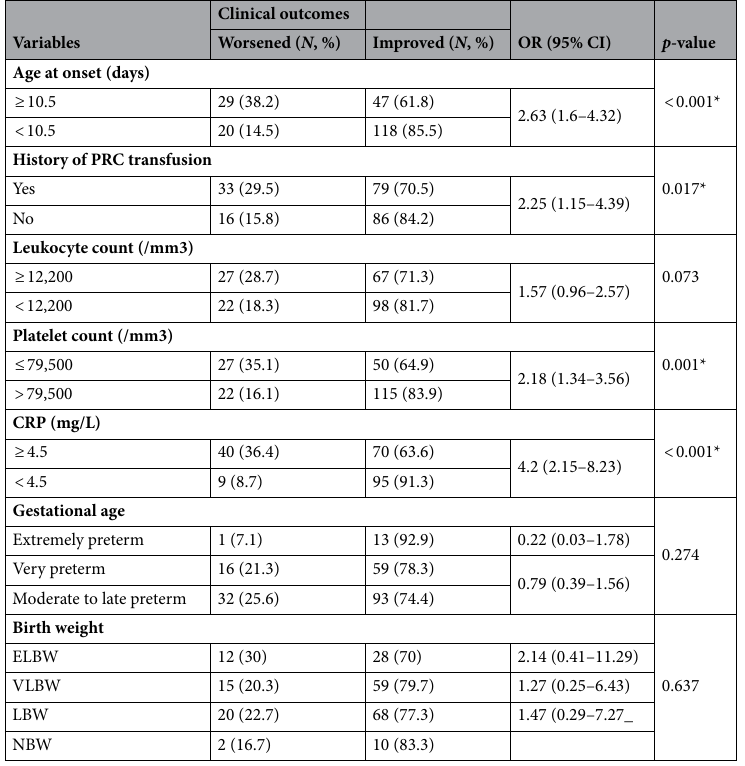
Table 2. Association between prognostic factors and clinical deterioration with NEC in our institution. *, p < 0.05; CI, confidence interval, OR odds ratio, NEC necrotizing enterocolitis, PRC packed red cell, CRP